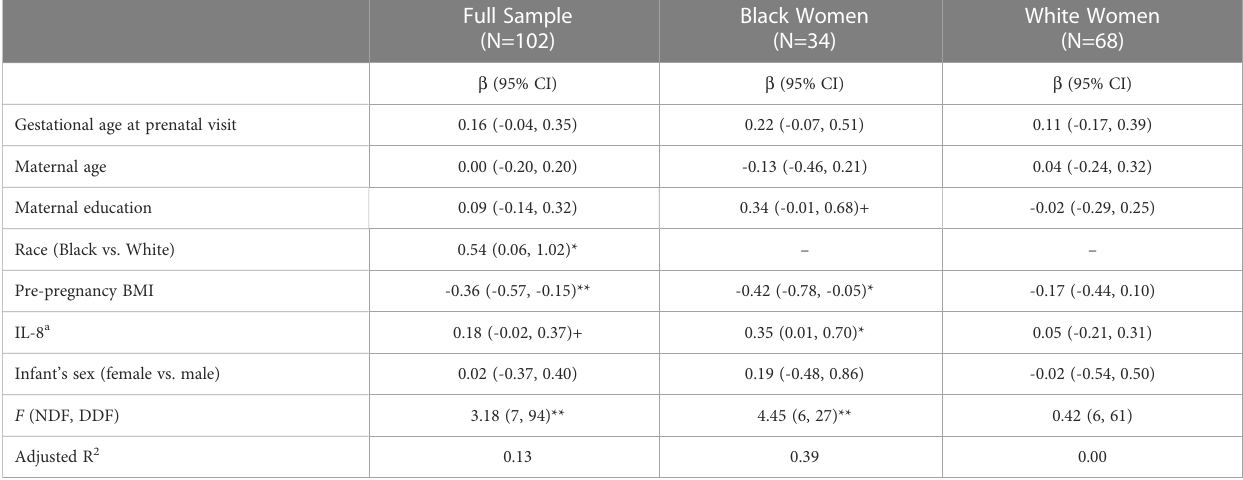
TABLE 4 Multiple linear regressions of PGH a in full sample and strati fi ed by race.